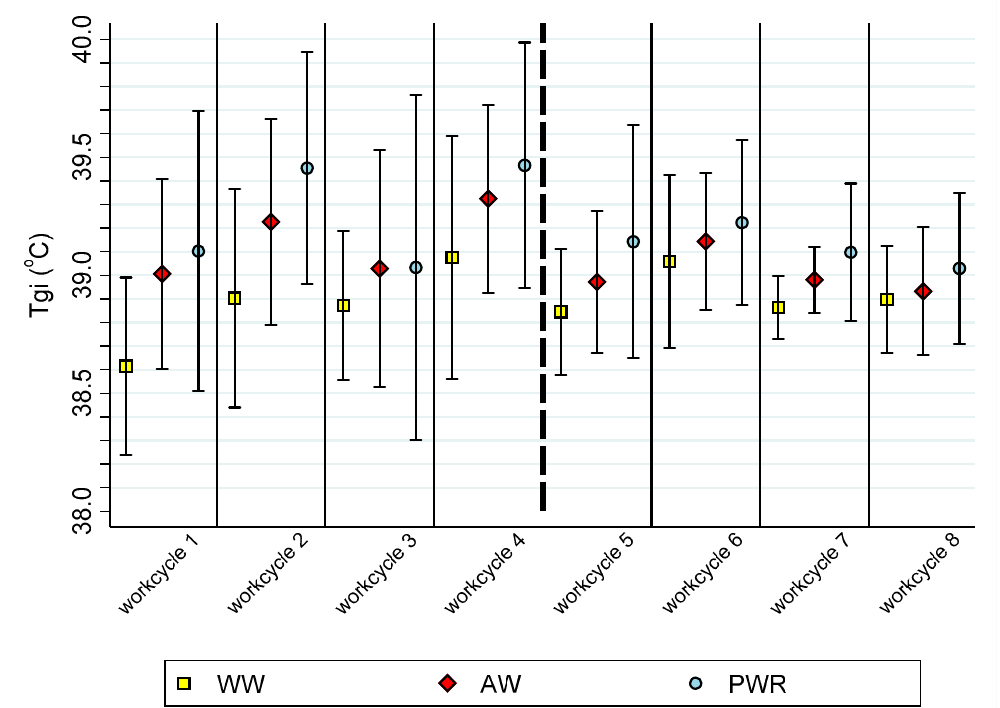
Figure 6. Mean (±SD) internal temperatures (Tgi °C) across eight search iterations representing three Figure 6. Mean ( ± SD) internal temperatures (Tgi ◦ C) across eight search iterations representing three